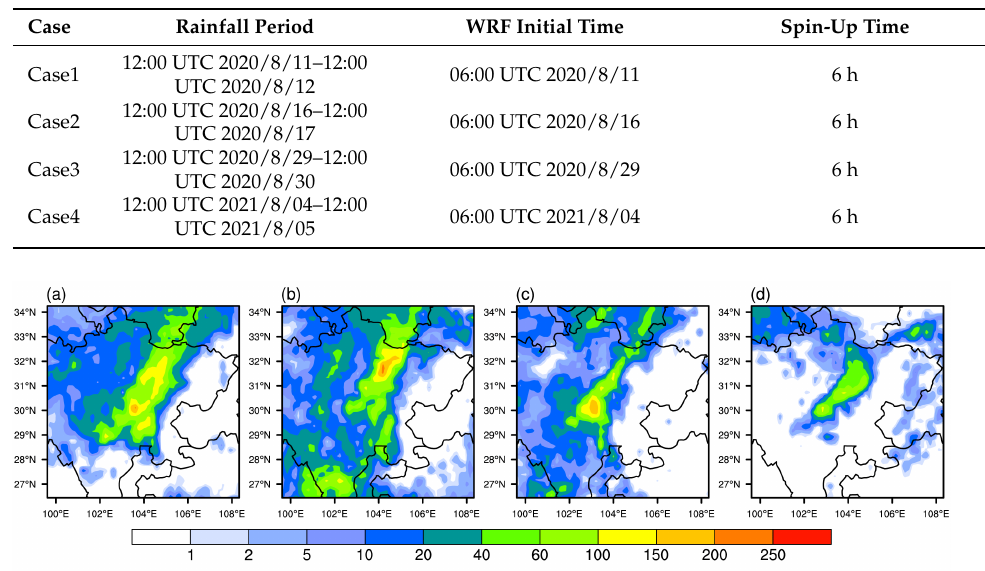
Table 5. Information of four cases studied in the present work.